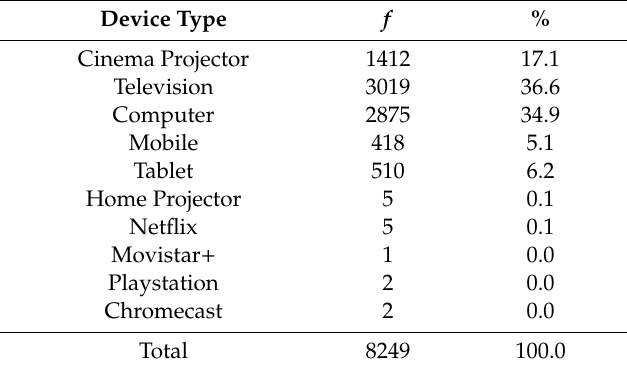
Table 12. Percentages and frequencies of devices used to watch movies by teacher’s degree